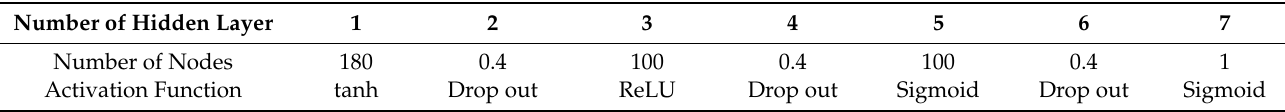
Table 7. The structure of the DNN model.